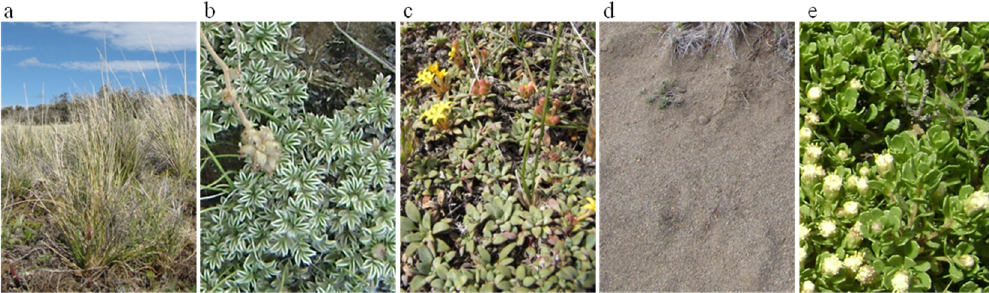
Figure 5. The five ground cover types considered in the study: ( a ) tussock grasses, ( b ) Acaena integerrima , ( c ) Oreopolus glacialis , ( d ) bare ground, and ( e ) Bacharis magellanica . Pinus contorta can establish itself in any of these substrates.